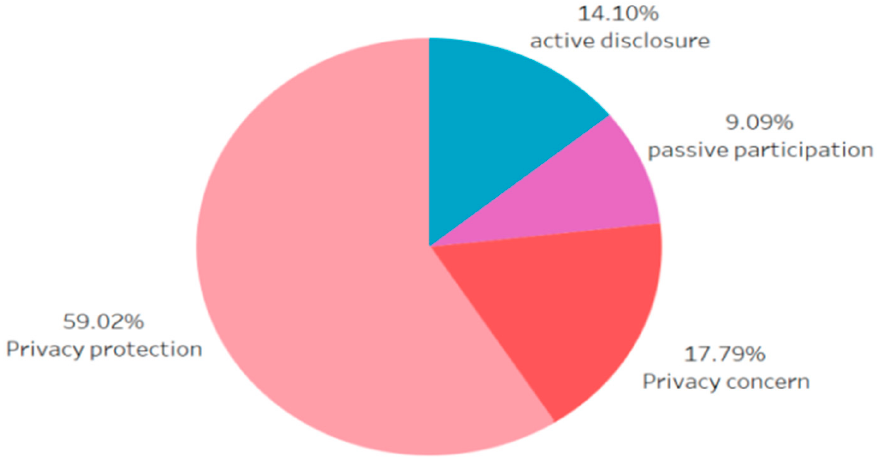
Figure 4. Single-level weight graph.